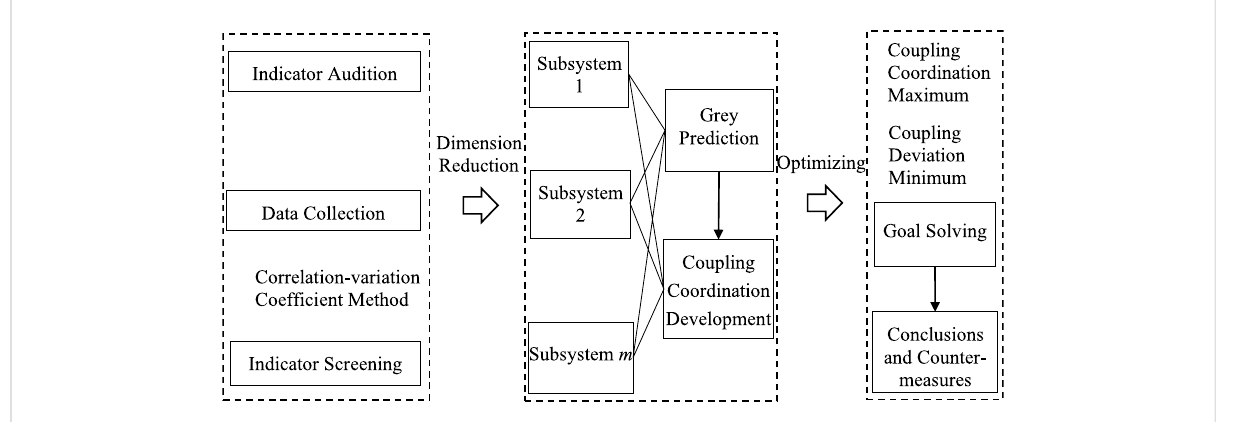
FIGURE 1 Analysis fl ow of optimization for coupling coordinated development of technology and fi